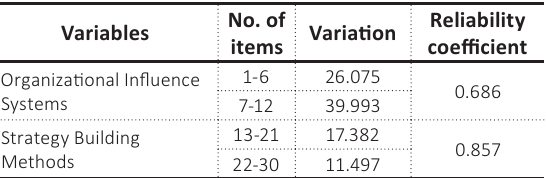
Table 3. Constancy of research